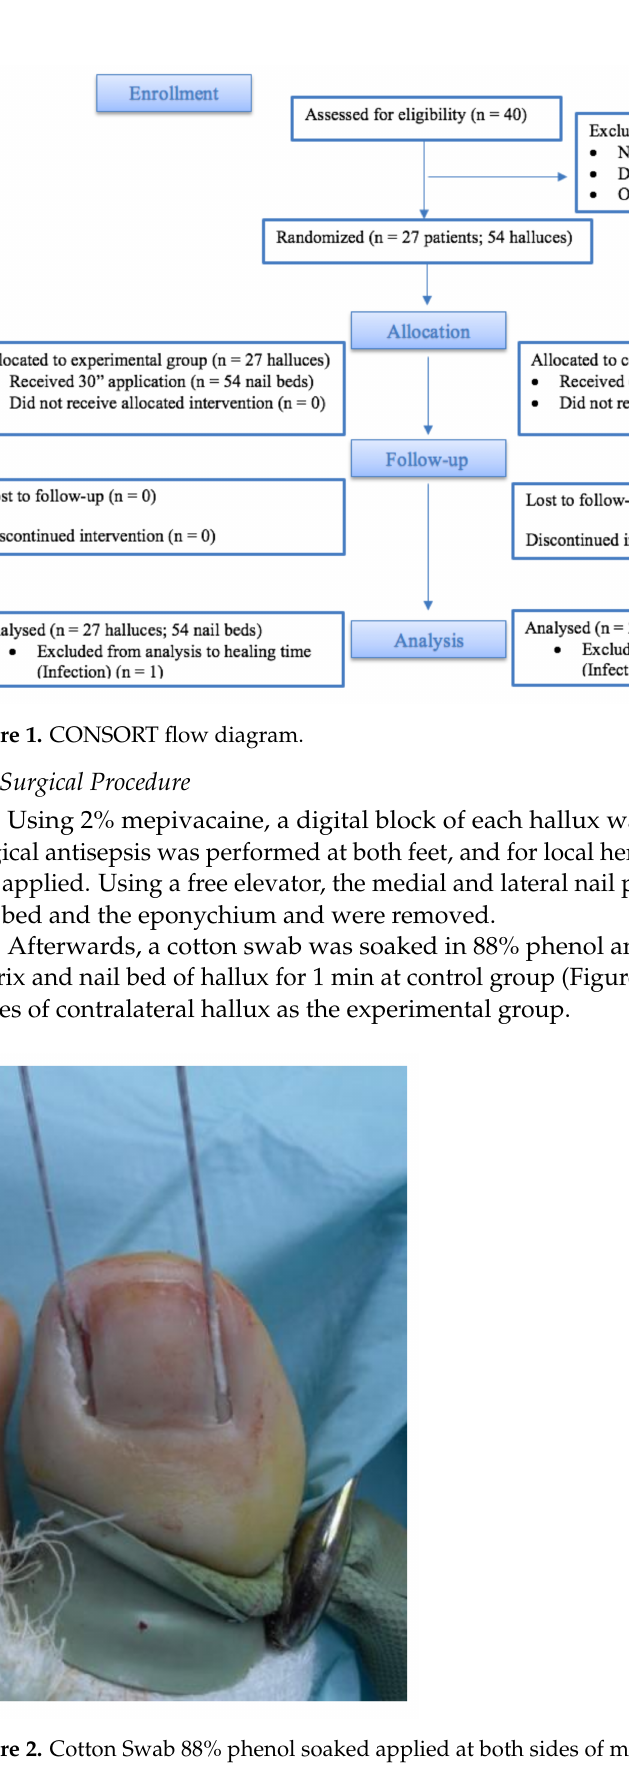
Figure 2. Cotton Swab 88% phenol soaked applied at both sides of matrix and the nail bed for 1-min at control